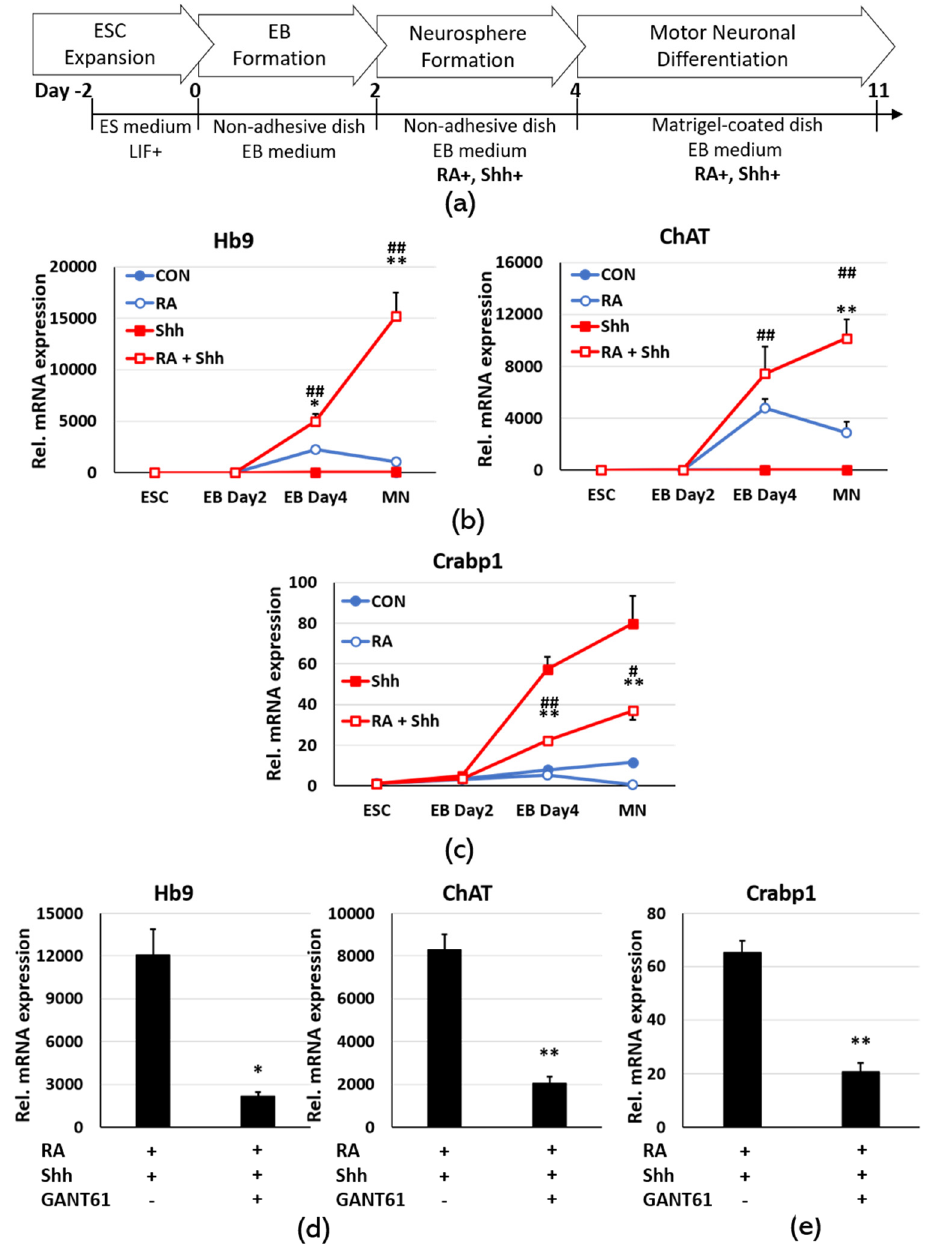
Figure 3. The expression of motor neuron markers and CRABP1 in embryonic stem cells (ESC) differentiation into motor neurons. ( a ) ESC-motor neuron differentiation procedure. ( b ) The results of qPCR analyses of motor neuron markers Hb9, ChAT. ( c ) The results of qPCR analyses of CRABP1, n = 3/group. The statistic results are presented as means ± SEM. * p < 0.05, ** p < 0.01; compared RA+Shh to RA only group. # p < 0.05, ## p < 0.01; compared RA+Shh to Shh only group. ( d ) The results of qPCR analyses of Hb9, ChAT, and CRABP1 with and without the Gli1/2 inhibitor, GANT61 ( n = 3/group). The results are presented as means ± SEM. * p < 0.05, ** p < 0.01. Abbreviations: EB = embryo body, RA = retinoic acid, Shh = sonic hedgehog.